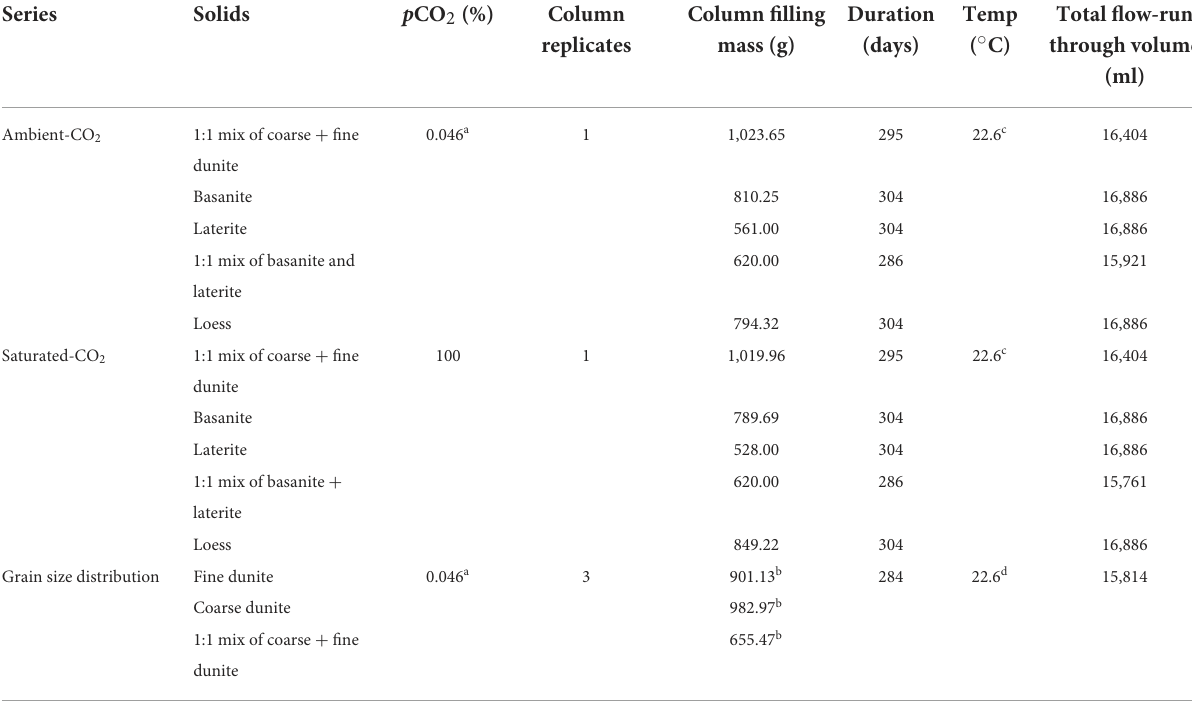
TABLE 3 Experimental series and parameters.